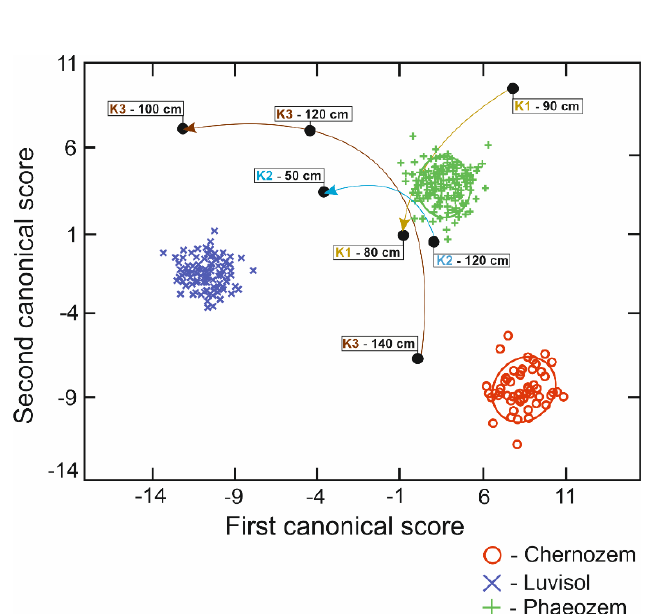
Figure 7. Canonical scores of topsoil samples from oak forests, beech forests and hornbeam/maple- dominated forests. 4. Discussion The simple relationship of an origination of Chernozems and the presence of steppe vegetation and continental climate in Central Europe was recently questioned due to pale- obotanic studies, which demonstrated the predominance of forest vegetation and strong human impacts during the Holocene. However, the other findings suggested that the early removal of forests and the expansion of pastures and arable lands since the Neolithic period could preserve or even restore some of these soils [28,29,36,37]. The determination of organic matter was successfully conducted by [19] in some buried Central European Chernozems using NIR spectroscopy. In this reconstruction, the bottom parts of the hu- mus horizons predominantly had a signature of grasslands, whereas the spectra from top- soil horizons indicated stronger influences of broadleaf forests. Contrary to [19], we be- lieve that such paleopedological reconstructions should involve the humus horizons of arable soils, in addition to grassland and forests soils, because we cannot exclude that the